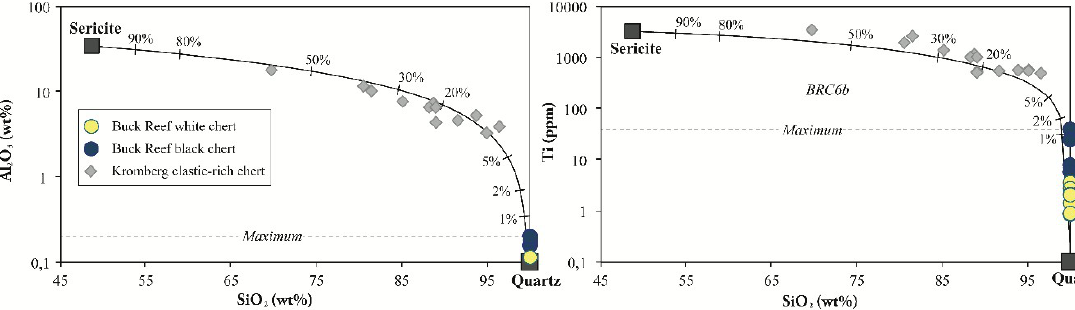
Figure 12. SiO 2 versus aluminium and titanium contents for Buck Reef chert samples. Clastic-rich cherts from the Kromberg type section [14] are shown for comparison. Solid lines are mixing curves between quartz and sericite endmembers. Sericite composition is from Ledevin et al. [40]. Sericite represents less than 0.1% of white cherts and no more than 1% of the black cherts.